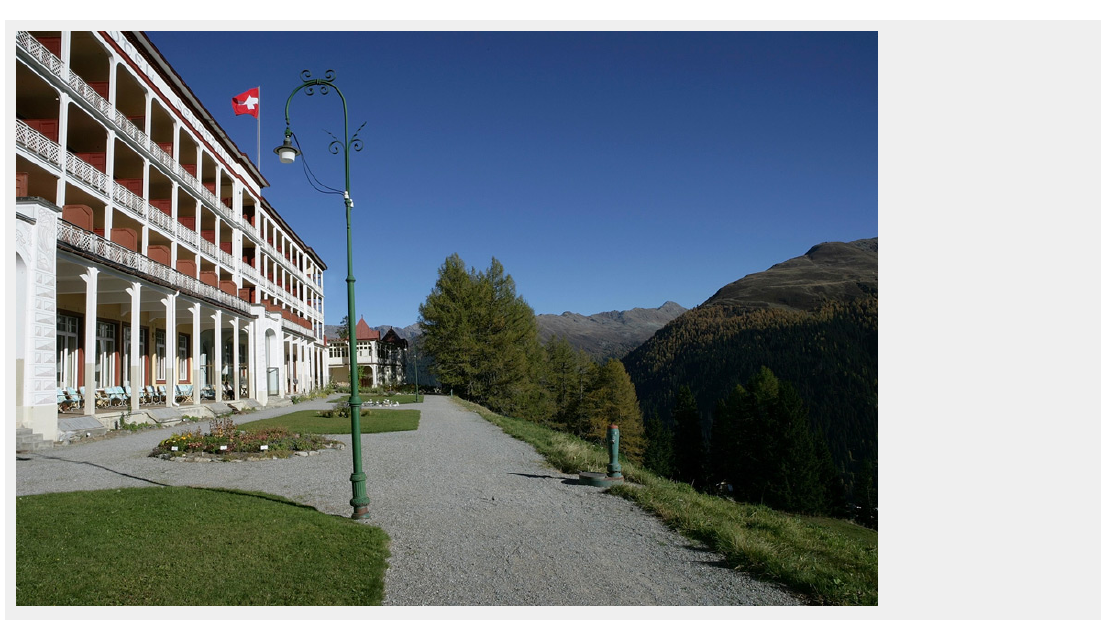
Figure 2 Typical architecture of a tuberculosis sanatorium. All patient rooms were supplied with balconies for prescribed doses of exposure of patients to sunlight and fresh air, which was believed to be beneficial at the time (Sanatorium Schatzalp, Davos, Switzerland). (Copyright by Davos Tourismus, Switzerland [swiss-image.ch/Christof Schuerpf], with